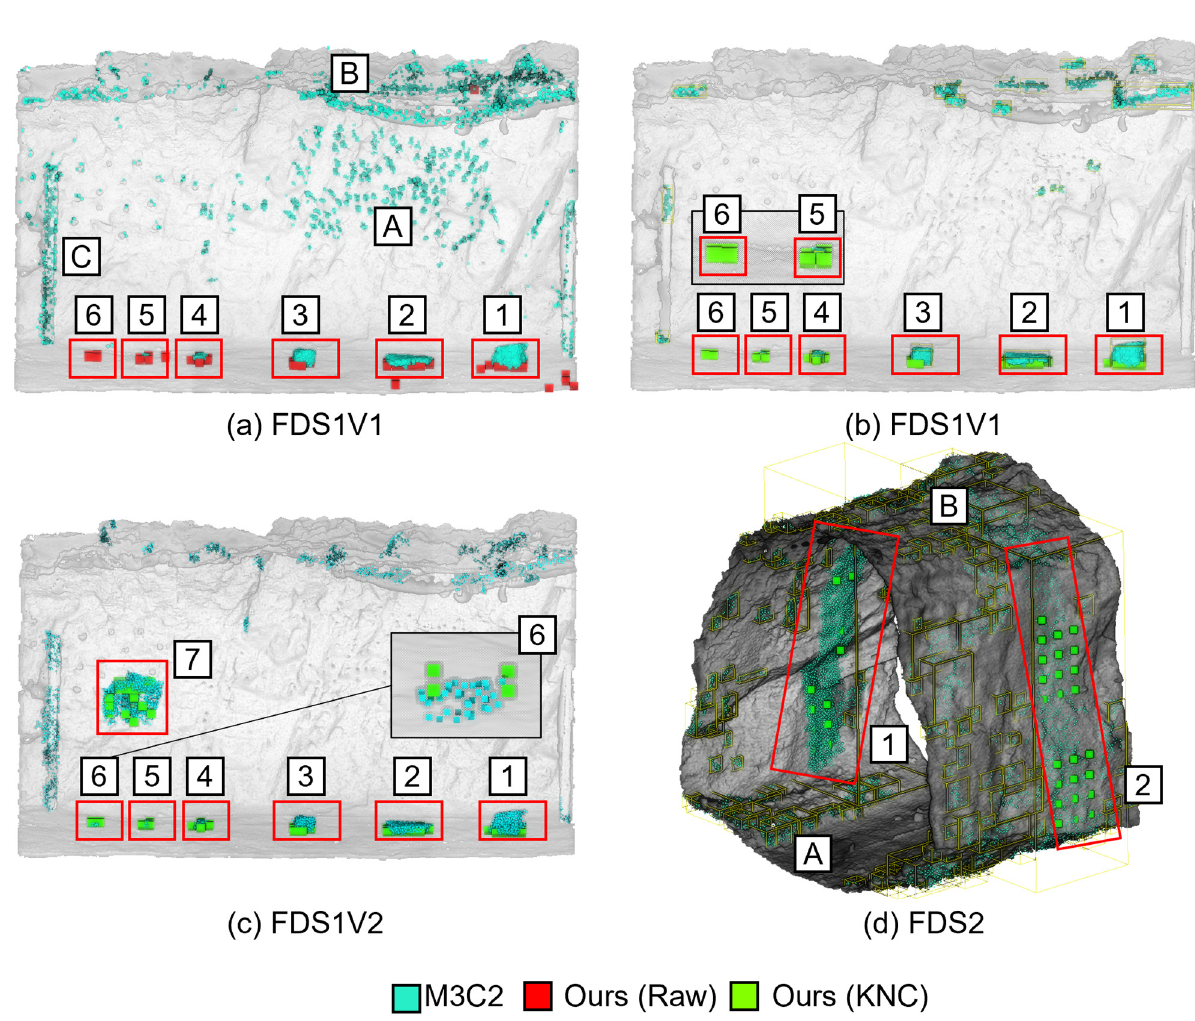
Figure 10. Change detection results of M3C2 workflow and ours on FDS1 and FDS2. ( a ) M3C2 without any filtering (no CCC/VDF) showing rockfall targets 1–6 and noisy M3C2 output (A-C). ( b )